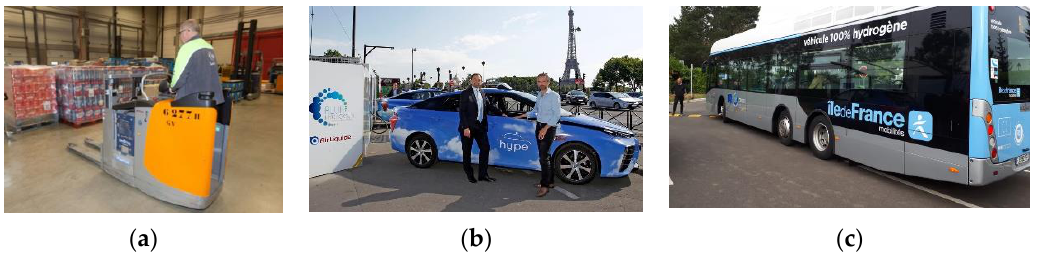
Figure 1. H 2 use in road vehicles. ( a ) Forklift truck (in a store deposit); ( b ) Taxi fleet (Paris region); ( c ) hydrogen bus (Paris region).